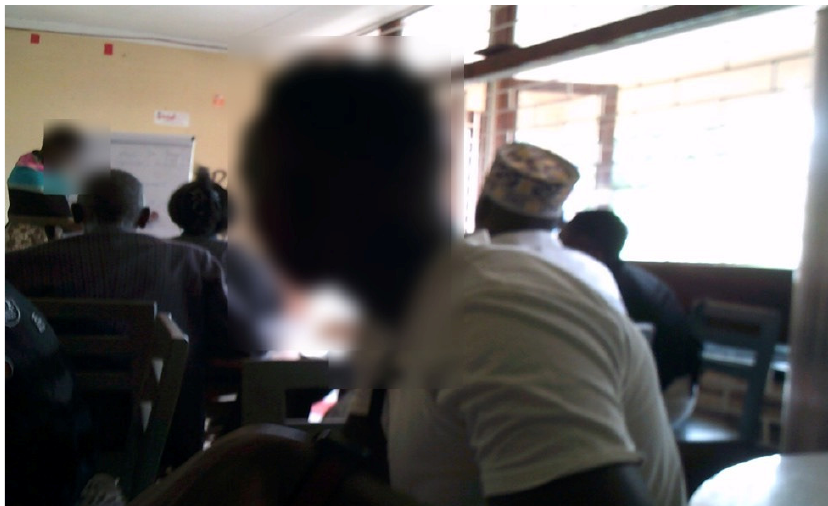
Figure 6. Participants attending day one of sexual harassment training.